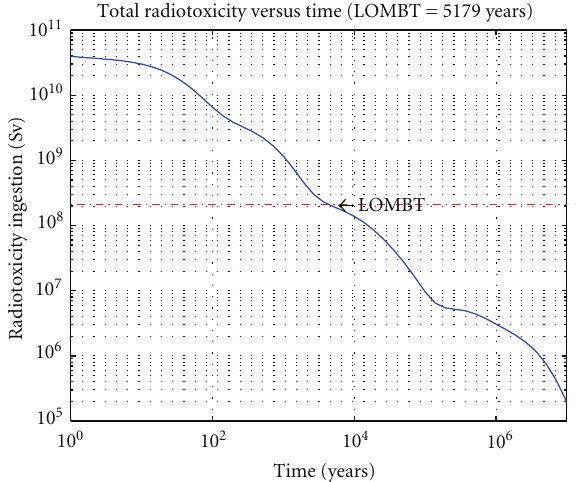
Figure 14: LOMBT of GCFR SNF end third cycle (FPs, Am, and Cm).